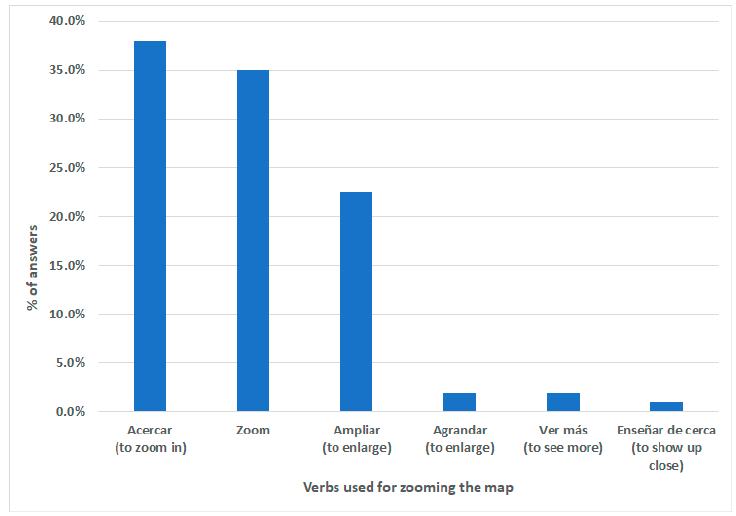
Figure 5. Verbs used for zooming in the map.